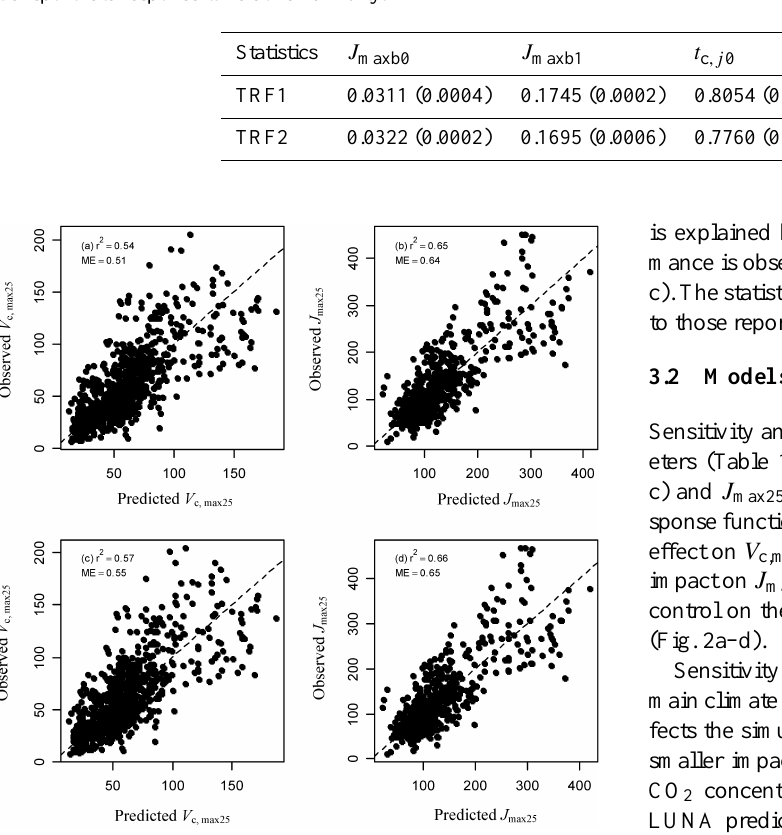
Table 1. Mean values and standard deviations (parentheses) of LUNA parameters estimated by using the Differential Evolution Adaptive Metropolis Snooker updater (DREAM (ZS) ) sampling technique for temperature response functions TRF1 and TRF2. The parameters include (1) J maxb0 (unitless): baseline proportion of nitrogen allocated for electron transport rate, (2) J maxb1 (unitless): electron transport rate response to light availability, (3) t c ,j 0 (unitless): baseline ratio of Rubisco limited rate to light limited rate and (4) H (unitless): electron transport rate response to relative humidity.